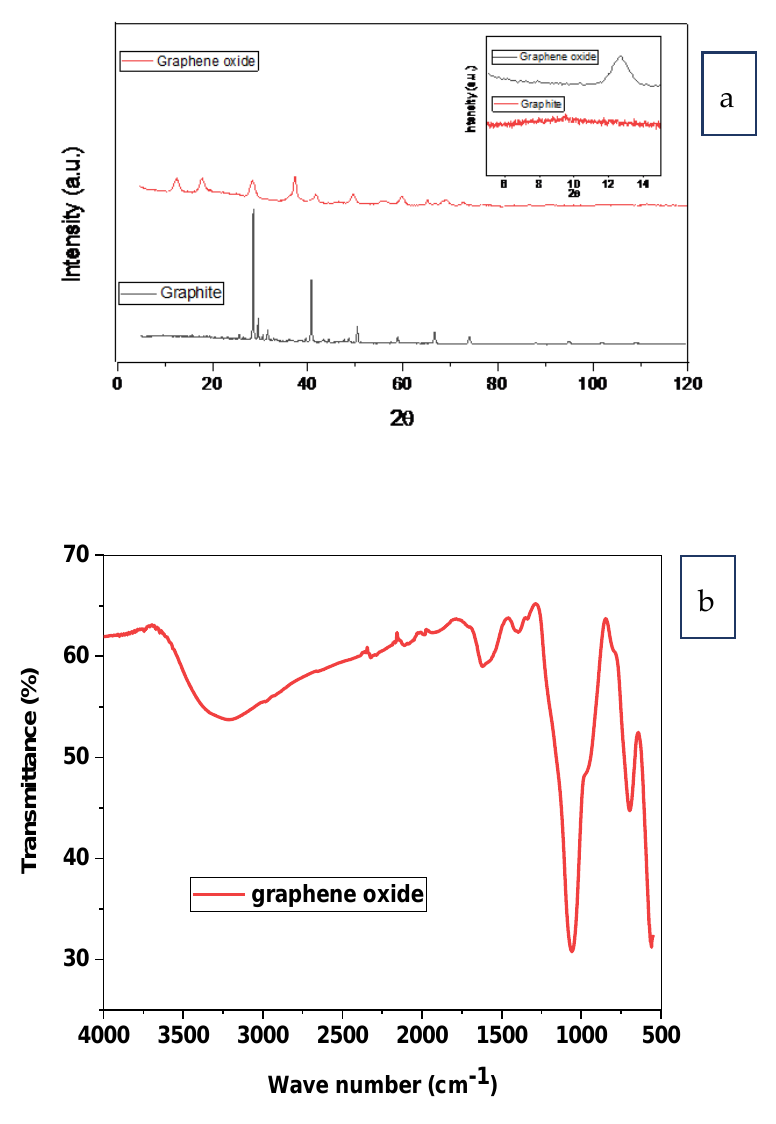
Figure 4. ( a ) XRD patterns of graphite and graphene oxide. The inset shows the characteristic graphene oxide extension peak and ( b ) FT-IR spectrum of graphene oxide.